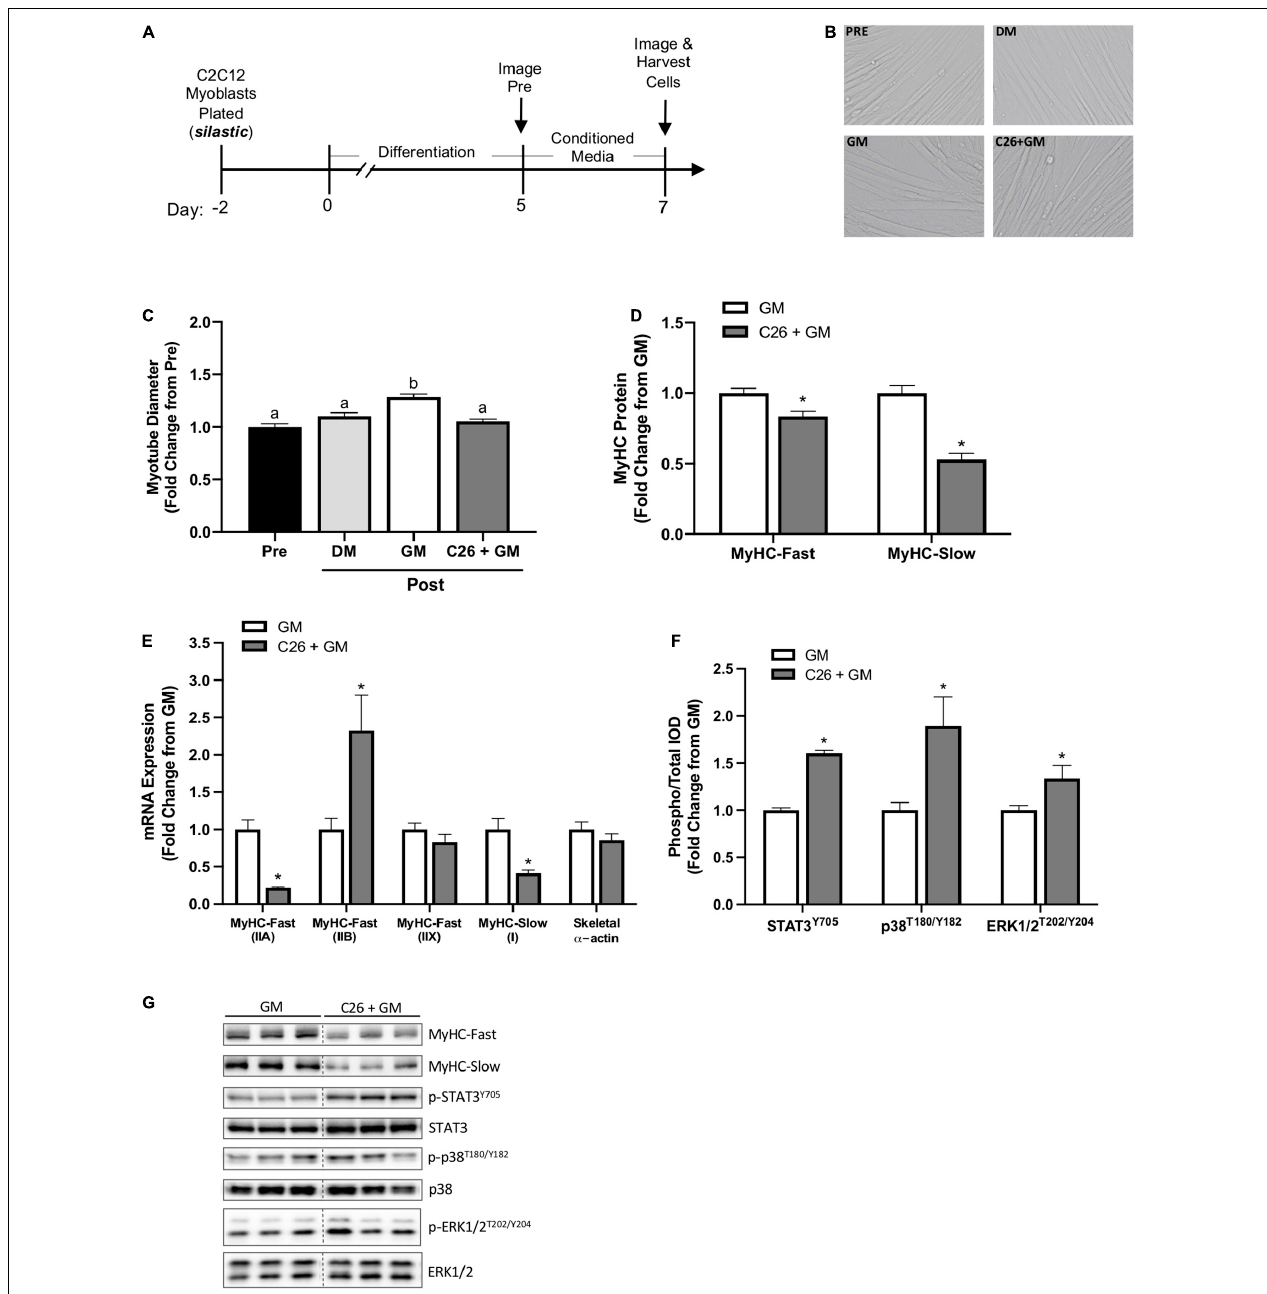
FIGURE 2 | C2C12 myotube growth suppression by colon-26 (C26) tumor-derived factors on type I collagen-coated silastic membranes. (A) Experiment overview: C2C12 myoblasts are plated on type I collagen-coated silastic Uniflex membranes in growth media (GM). After 48 h at ∼ 85% confluence, differentiation media (DM) is added, which corresponds to day 0 of differentiation. On day 5 of differentiation, myotubes are fully formed, and conditioned media (CM: GM, C26 + GM) diluted with 50% serum-free DMEM is added to wells for 48 h. Myotubes are imaged Pre and Post 48-h incubation with DM, GM, or C26 + GM for diameter measurements. Cells are harvested for protein and RNA on day 7 of differentiation. (B) Representative × 20 brightfield images. (C) Myotube diameter quantification Pre (day 5; n = 162 myotubes) and Post 48 h DM, GM, or C26 + GM incubation ( n = 162–378 myotubes/group). (D) Myosin heavy chain (MyHC)-Fast (type II fibers) and MyHC-Slow (type I fibers) protein expression measured by Western blotting (Fast: n = 18–21/group; Slow: n = 9/group). (E) MyHC-Fast type IIA (Myh2), type IIB (Myh4), type IIX (Myh1), MyHC-Slow type I (Myh7), and skeletal muscle α -actin (Acta1) mRNA expression ( n = 6/group) calculated using the 2 − (cid:49)(cid:49) Ct method with GAPDH as a housekeeping gene. (F) Ratio of phosphorylated (p-) to total protein expression of signal transducer and activator of transcription 3 (STAT3 Y 705 ) ( n = 12–15/group); p38 T 180 / Y 182 mitogen-activated protein kinase (MAPK) ( n = 6/group), and extracellular signal-regulated kinase 1/2 (ERK1/2 T 202 / Y 204 ) ( n = 6/group) measured by Western blotting. (G) Representative Western blotting images: dashed line represents different areas of the same gel. Data are presented as means ± SEM as a fold change from GM. One-way ANOVA (C) or Student’s unpaired t -test was performed to determine differences. Lowercase letters (a, b, and c) denote significant difference between groups; *significant from GM control. Statistical significance set at p ≤ 0.05.